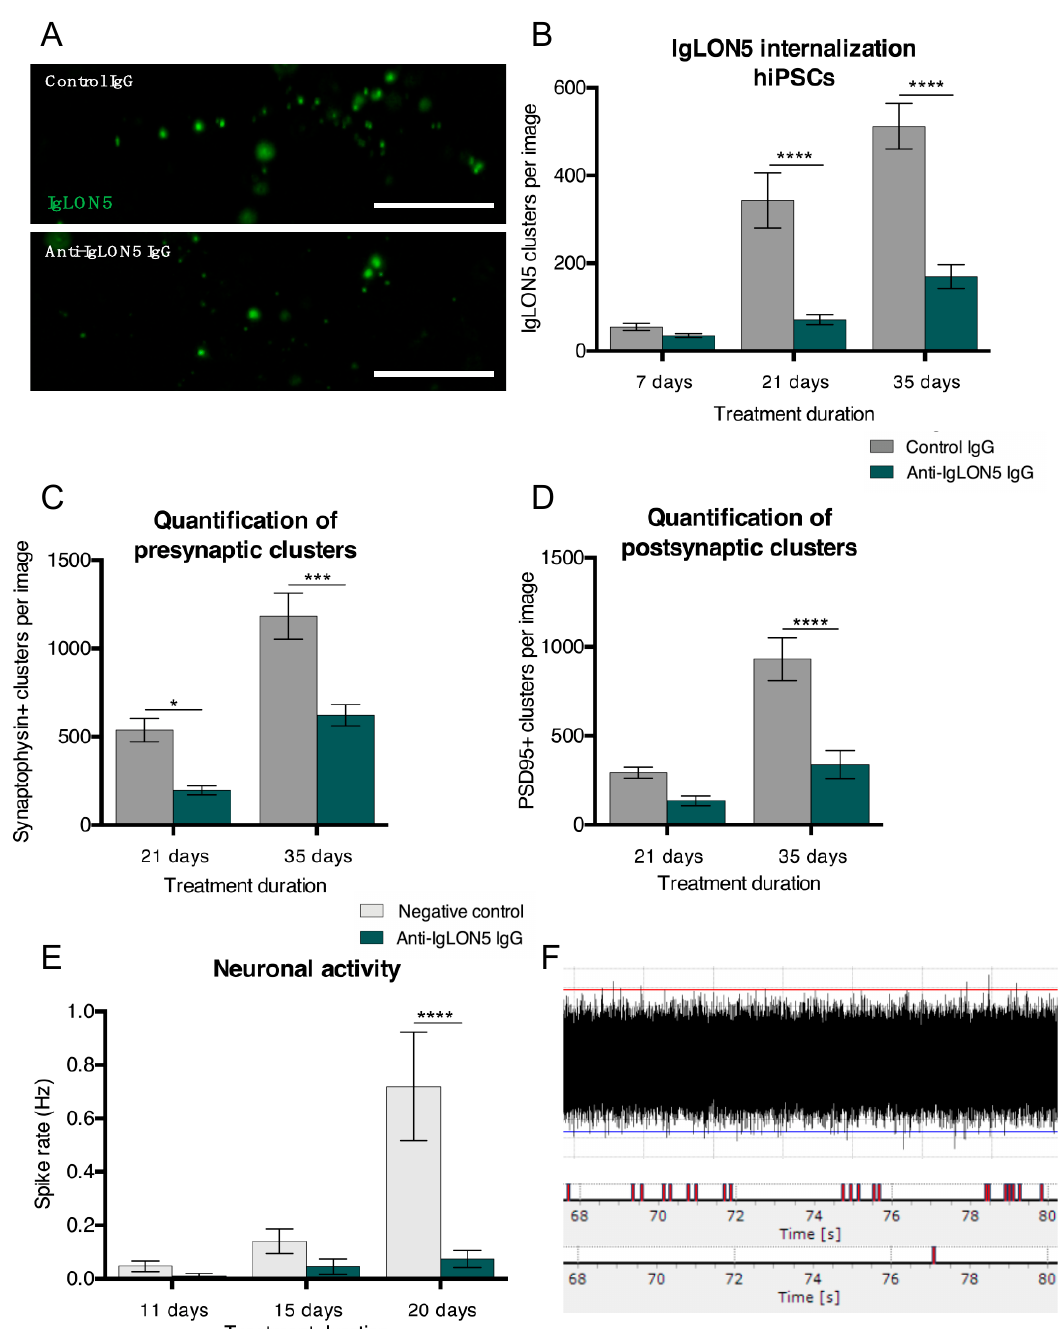
Figure 3. Anti-IgLON5 antibodies reduce cell surface IgLON5 clusters, synaptic proteins, and neuronal activity. Indirect immunofluorescent staining of human induced pluripotent stem cell (hiPSC) cultures treated with control IgG or anti- IgLON5 IgG ( A ). Quantification of IgLON5-positive clusters in hiPSC cultures revealed a significant reduction after 21 and 35 days of antibody exposure ( B ) ( n = 9). Immunostaining for the synaptic proteins synaptophysin and PSD95 revealed a decrease in synaptophysin clusters after 21 days of exposure and in both synaptophysin and PSD95 clusters after 35 days of exposure ( C , D ) ( n = 6). Multi electrode array (MEA) analysis of hiPSC cultures showed the expected increase in neuronal activity as they matured, however, the spike rate of neurons treated with anti-IgLON5 IgG was significantly lower than that of untreated neurons ( E ) ( n = 5). Example of a MEA data sample is shown in ( F ) (top). When the signal crosses the threshold (horizontal lines) a spike is registered. Registered spikes from a single electrode in a well with an untreated culture (F, middle) and an anti-IgLON5 IgG-treated culture (F, bottom) during a 15 s period. Statistical analysis: two-tailed unpaired t -test or Two-way ANOVA followed by Sidak’s multiple comparisons test (*: p < 0.05, ***: p < 0.001, ****: p < 0.0001). Scale bar length: 5 µ